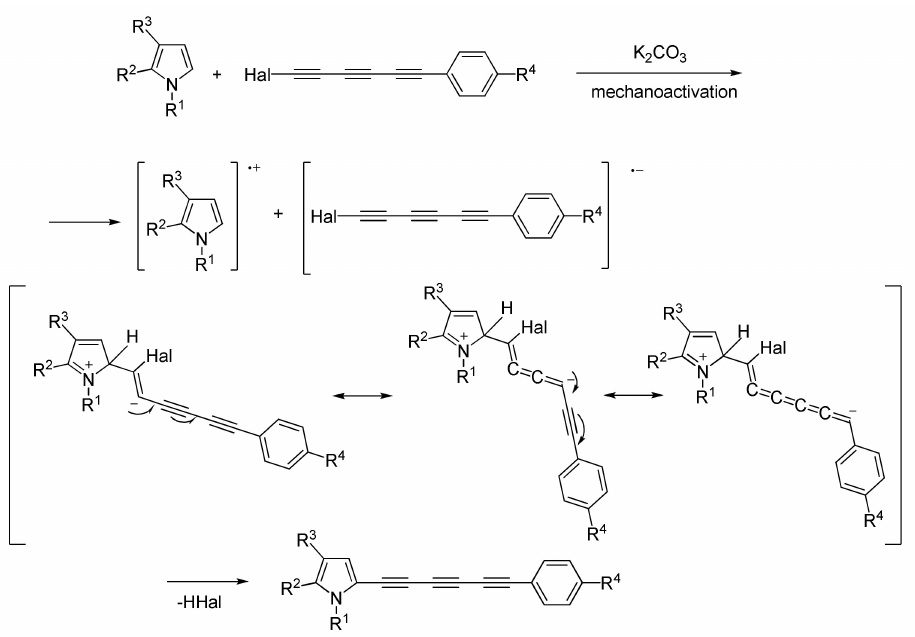
Scheme 23. Proposed mechanism of long-chain stabilization of a radical intermediate